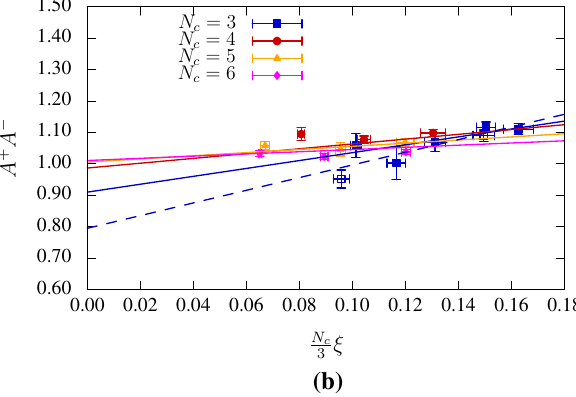
Fig. 6 Chiral extrapolation of A + and the product A + A − . The data points are also shown in Table 4. Empty squares for N c = 3 indicate a finer lattice spacing. Solid lines indicate a simultaneous chiral and N c